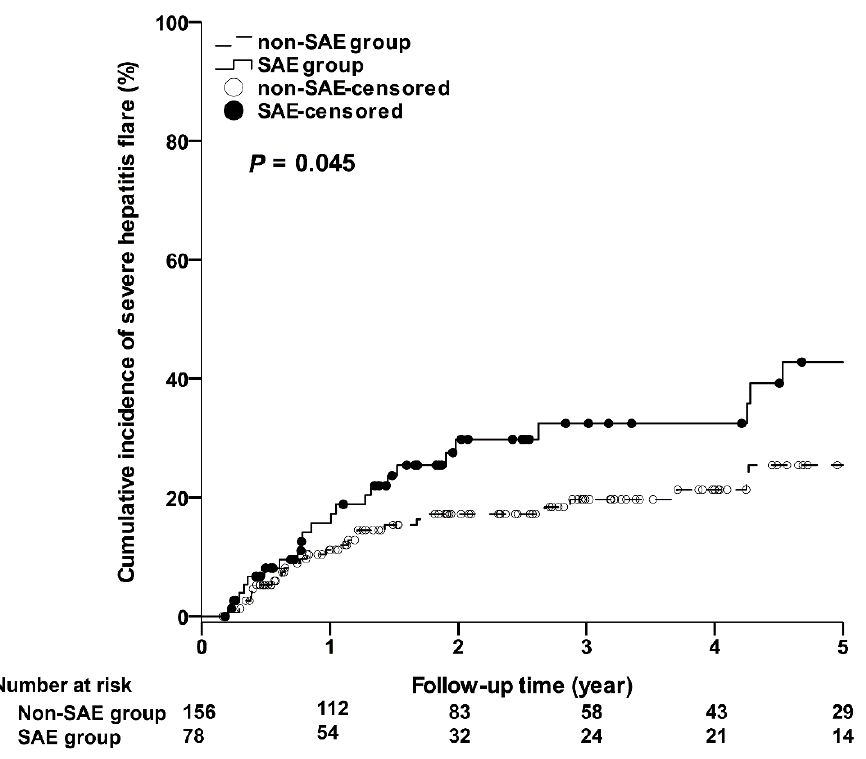
Figure 2. The cumulative incidences of severe clinical relapse. SAE, severe acute exacerbation.